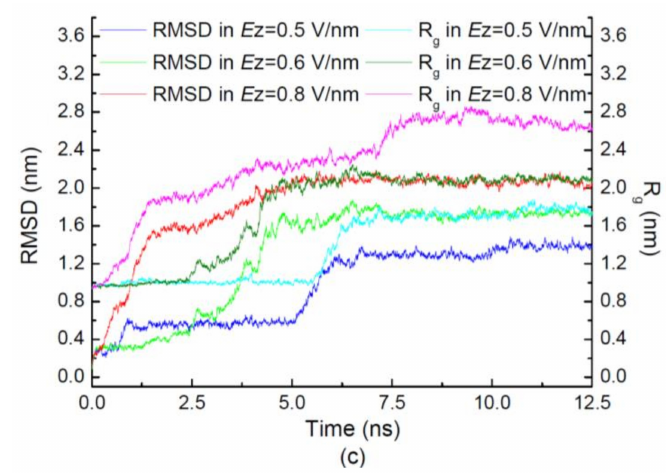
Figure 2. (Color online) Time evolution of radius of gyration R g of the protein 1BBL exposed in the external electric fields with different electric strengths ( a ), along three different directions ( b ), and the numerical comparison of R g and RMSD ( c ),